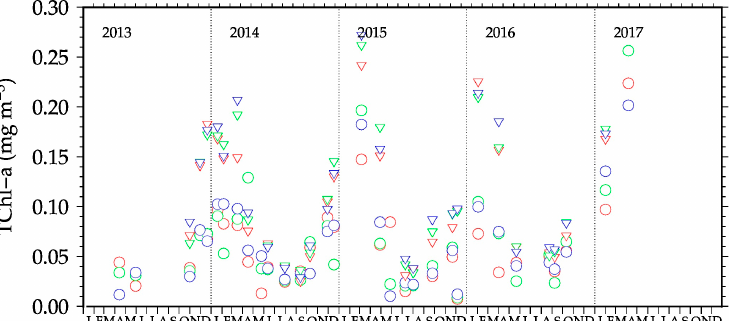
Figure 12. Total chlorophyll- a at various depths in the surface layer at the MSEA site (red: 2 m; green: 10 m; blue: 20 m). Circles are for fluorometric [TChl- a ] determinations and triangles for HPLC.